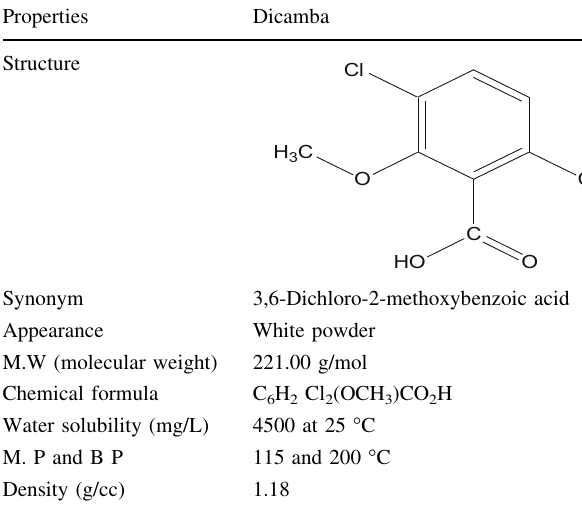
Table 1 Physical and chemical properties of